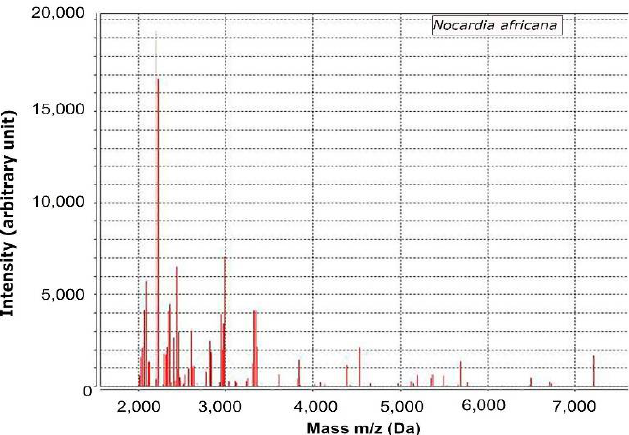
Figure 2. Analysis of MALDI-TOF mass spectrometry in the present case. Table 1. Antibiotic sensitivity results of Nocardia africana in this case.